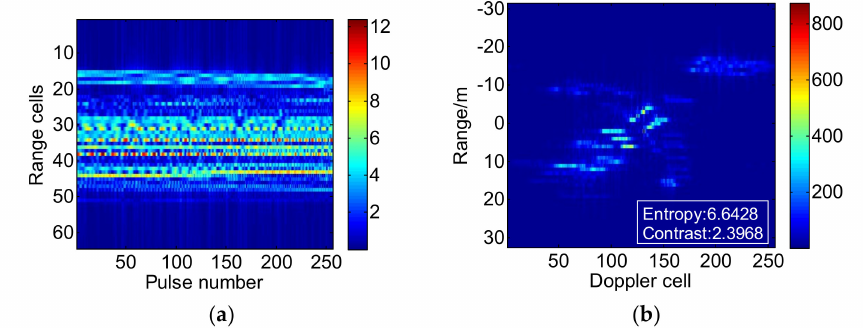
Figure 12. Data of Boeing 727. ( a ) 256 echo pulses; ( b ) ISAR image based on range-Doppler algorithm.